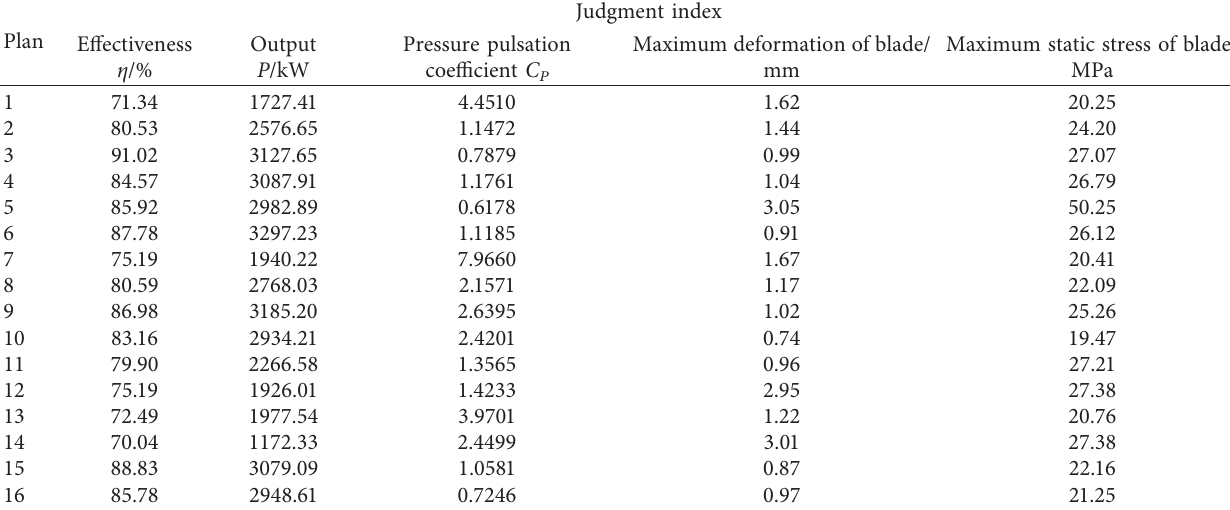
Table 6: Calculation results of various design schemes.